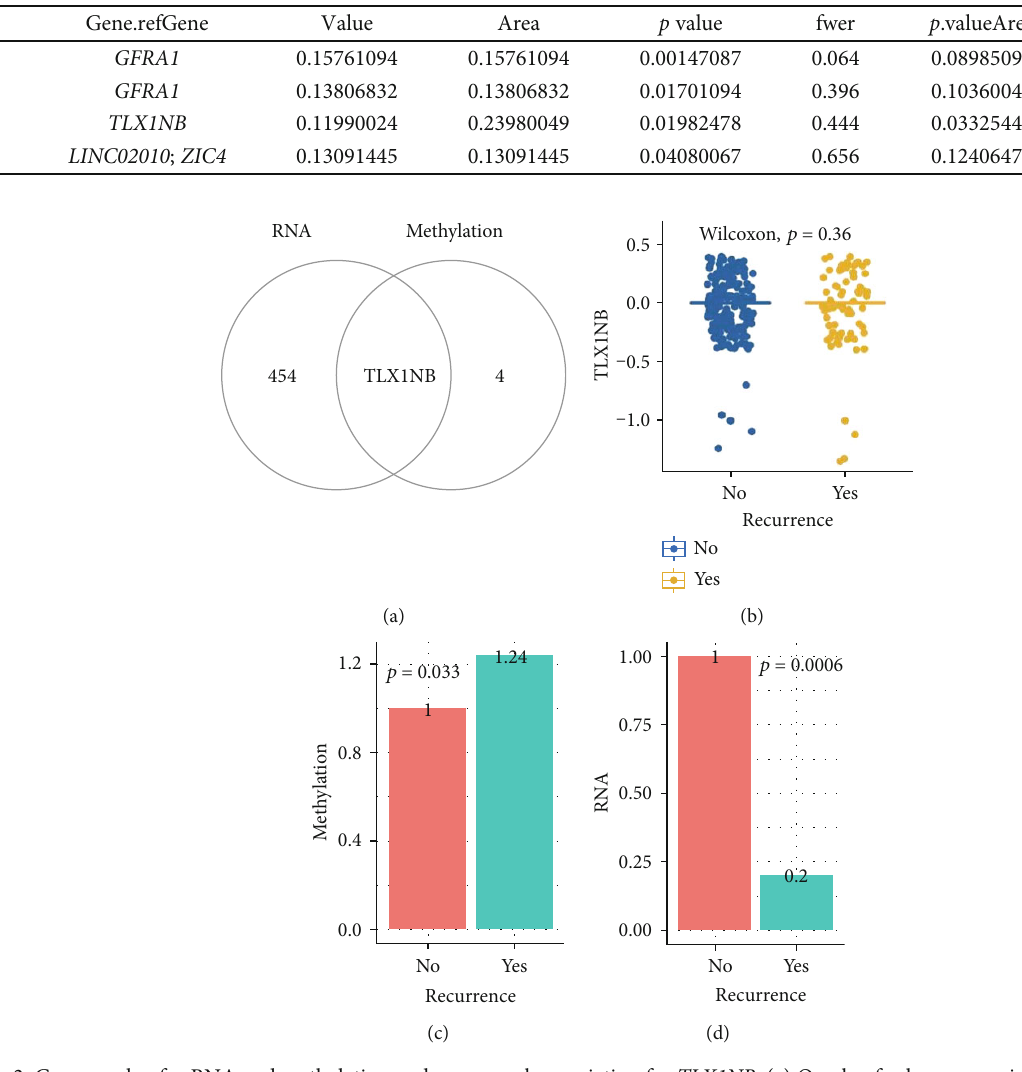
Figure 2: Gene overlap for RNA and methylation and copy number variation for TLX1NB . (a) Overlap for low expression at the RNA level (threshold: adjusted p value < 0.05, fold change > 2 ) and high methylation at the DNA level (threshold: methylation levelchange for DMRs ð differentially methylated regions ÞÞ >0 : 1 ). (b) Copy number variation analysis for TLX1NB between recurrence and nonrecurrence. A p -value < 0.05 was selected as the threshold. (c) Methylation level of TLX1NB between recurrence and nonrecurrence. A p value < 0.05 was selected as the signi fi cance threshold. (d) RNA expression level of TLX1NB between recurrence and nonrecurrence. A p value < 0.05 was selected as the signi fi cance